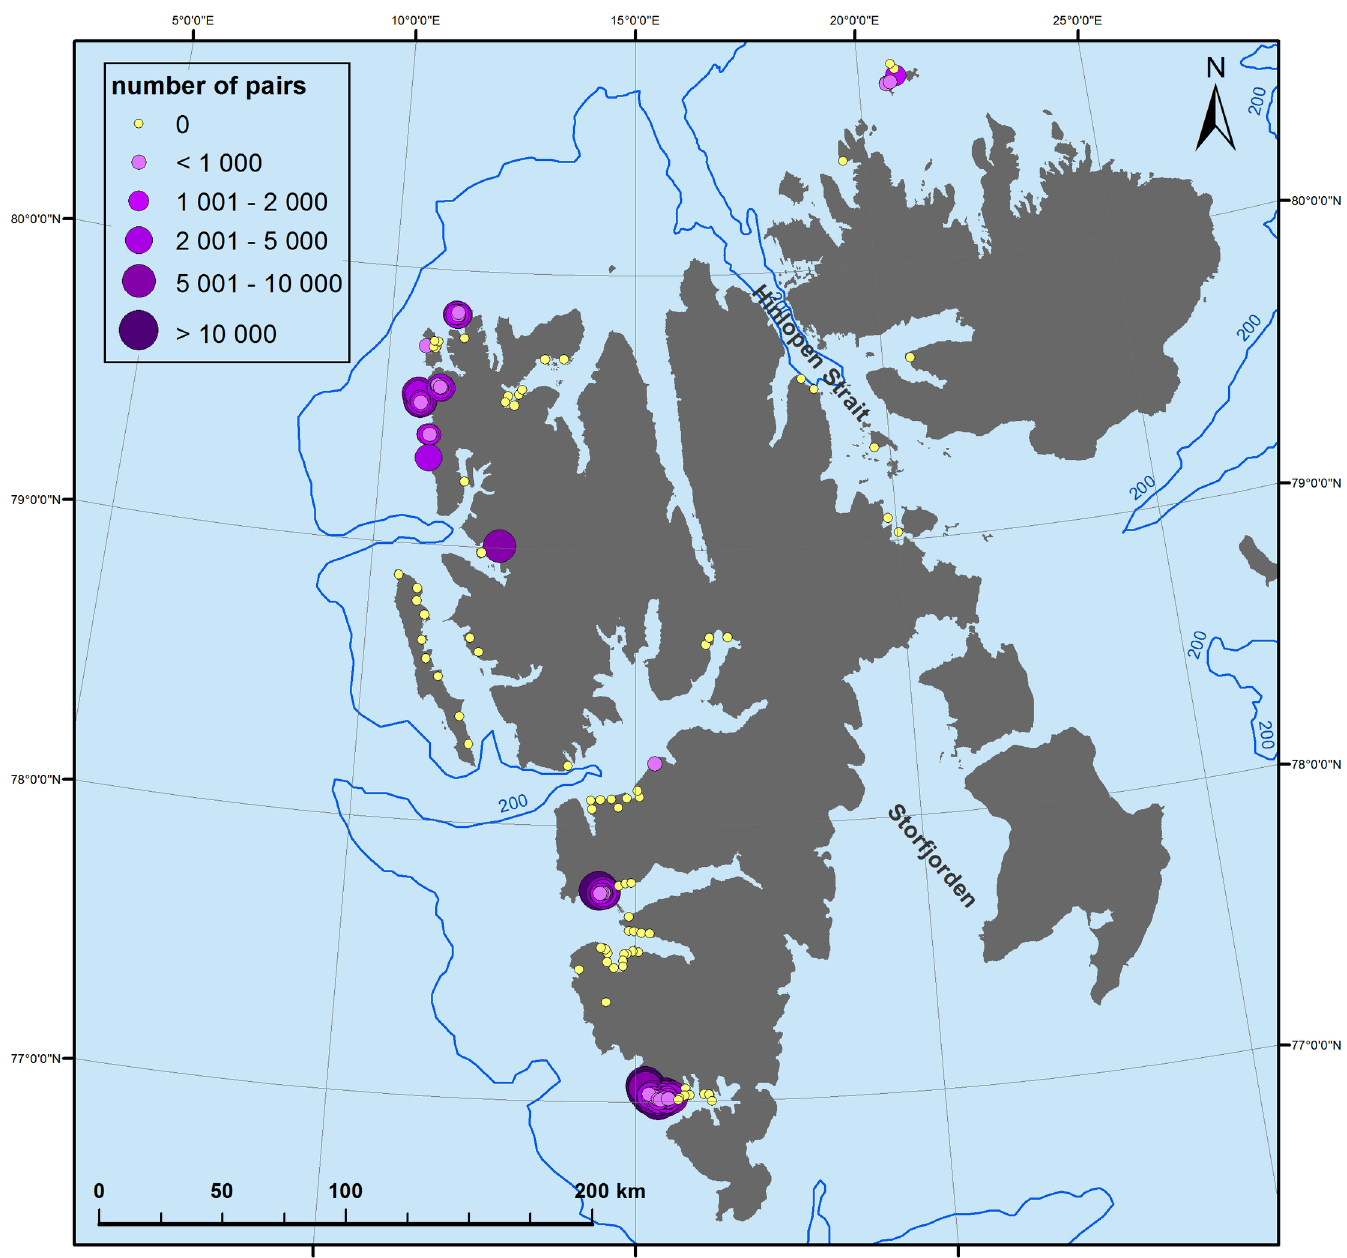
Fig 4. Little auk colony distribution in Spitsbergen. A size of the dot corresponds to a colony size (number of breeding pairs). Background (bathymetry and contour map): NOAA Satellite Maps.